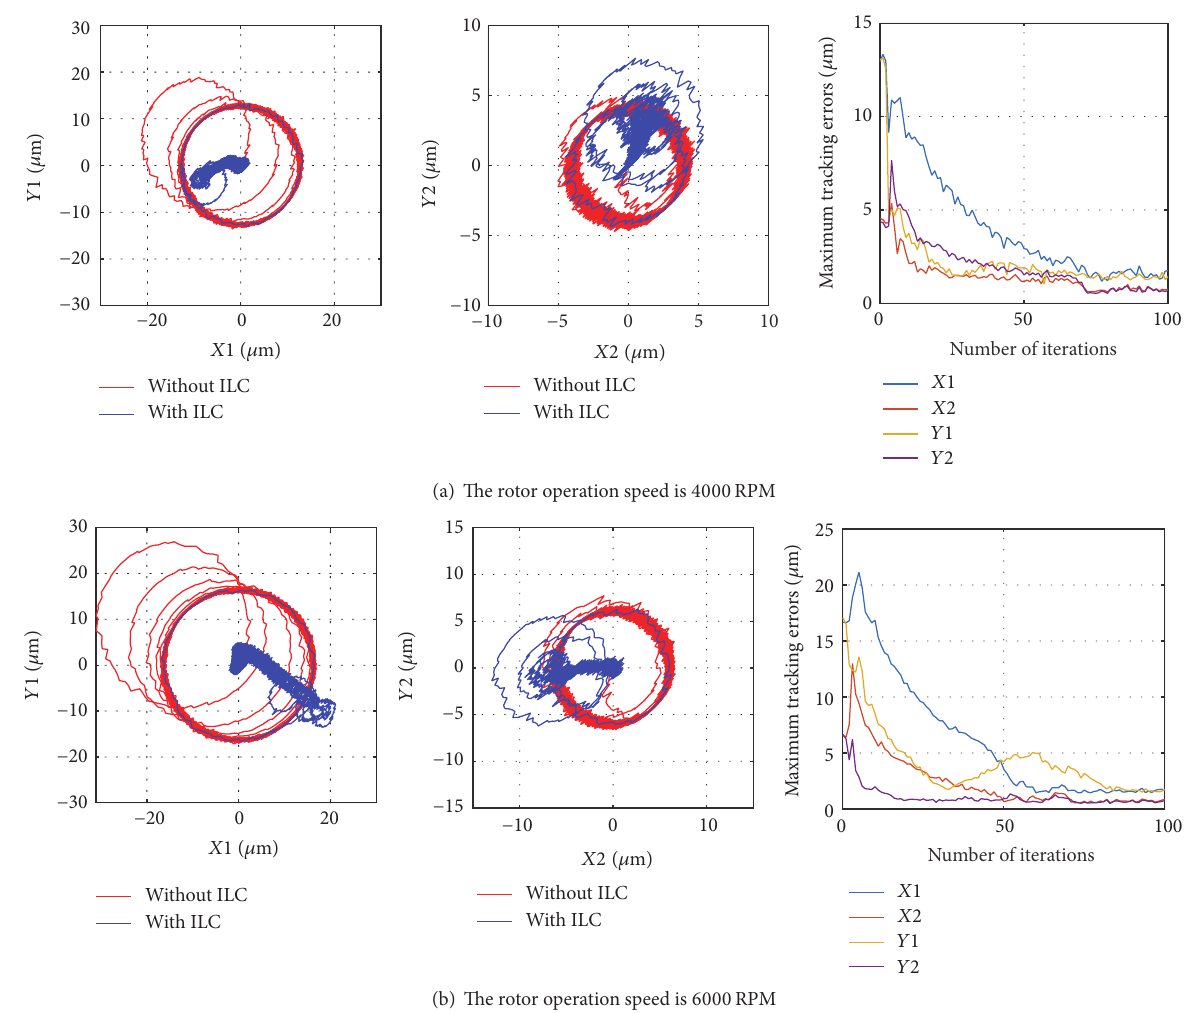
Figure 16: Orbits of the center of the shaft and the maximum tracking errors versus number of iterations with different rotor operation